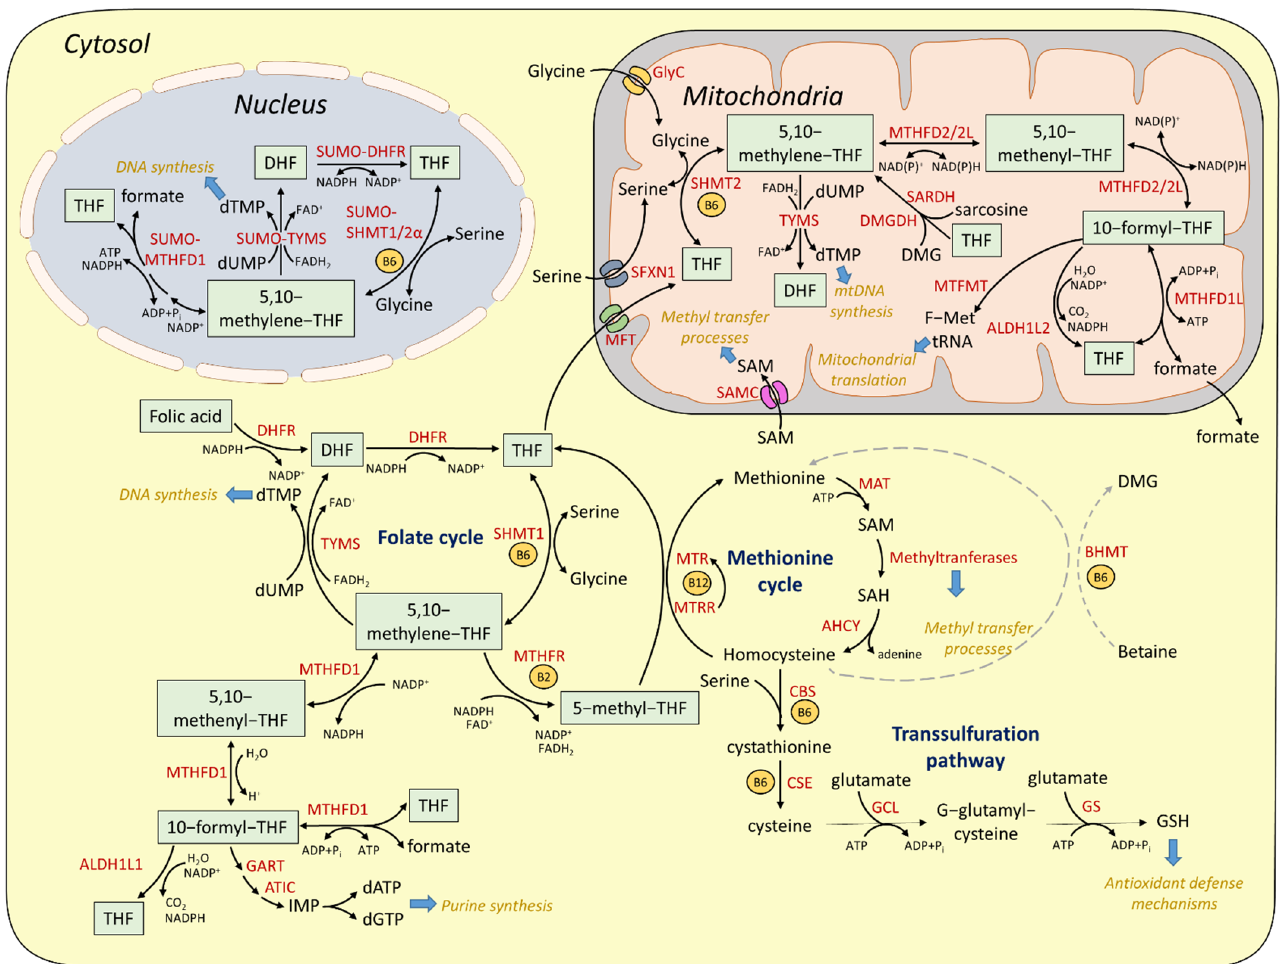
Figure 1. One − carbon metabolic pathways. Intersections of OCM pathways in cytosolic, nuclear, and mitochondrial compartments, based on mammalian systems. The involved folate forms are depicted in green boxes, while the respective enzymes are written in red.